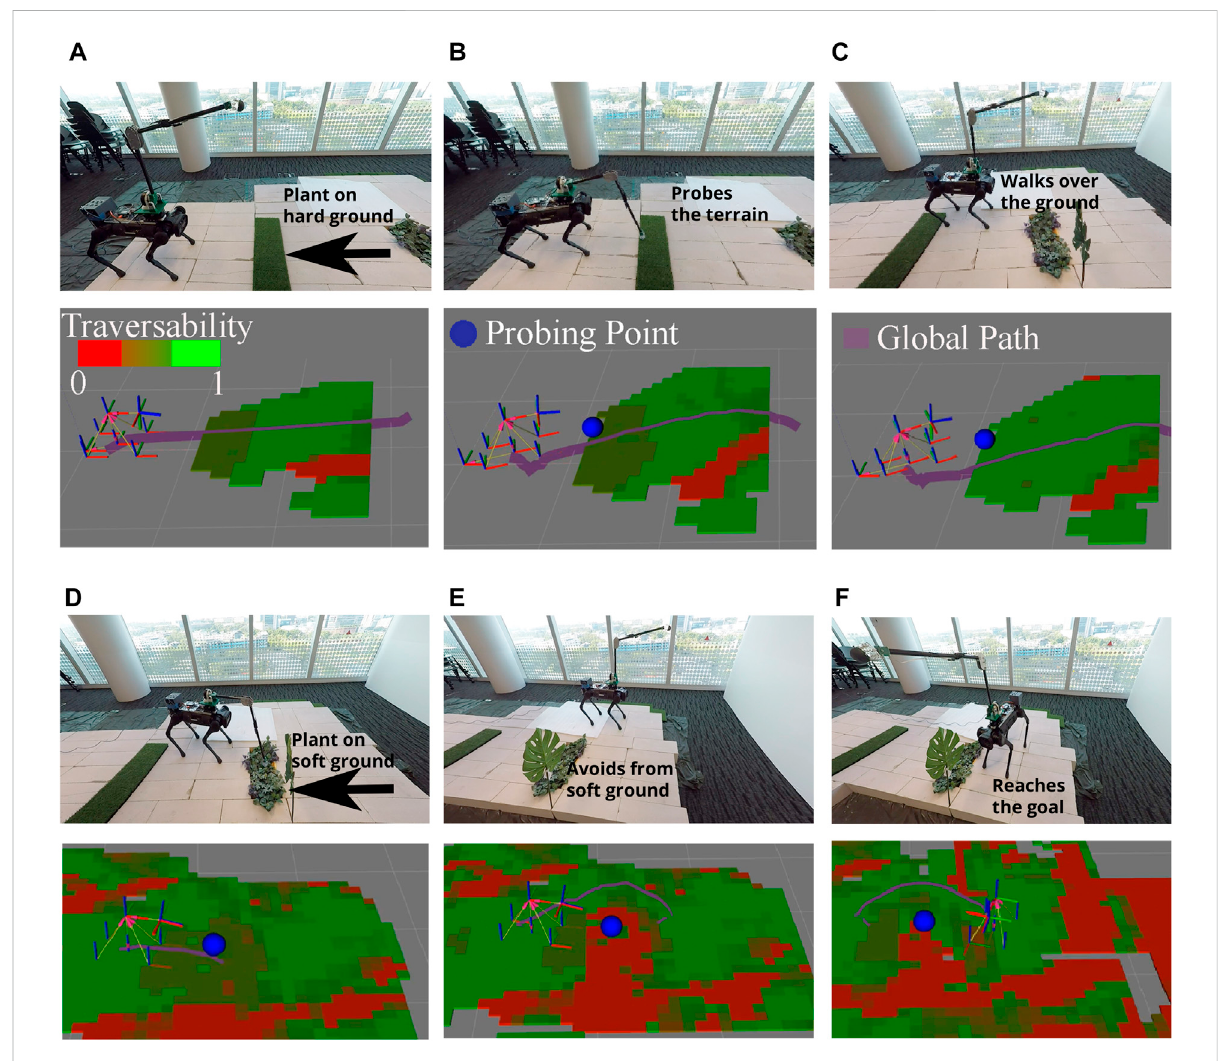
FIGURE 7 Snapshots ofreal-time experimentusingtraversability – navigationpipelinewith terrainprobing: (A) robotdetects semanticallyknownplant; (B) probing arm probes the plant area and (C) detects traversable soil on plant and walks over it; (D) the robot observes the plant again; and (E) probing arm probes the plant area, detects untraversable soil on plant and avoids it, and (F) safely reaches the desired